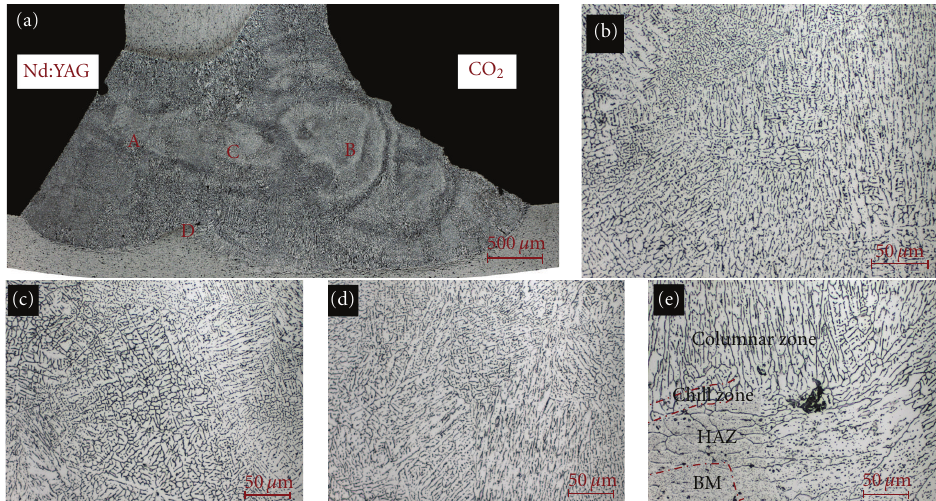
= 7 . 8KW, υ = 4m/min). (a) Macrographs of the weld seam; (b) high Figure 6: OM micrographs of T-joint (welding parameter: P CO 2 magnification of spot A; (c) high magnification of spot B, (d) high magnification of spot C, and (e) High magnification of spot D.